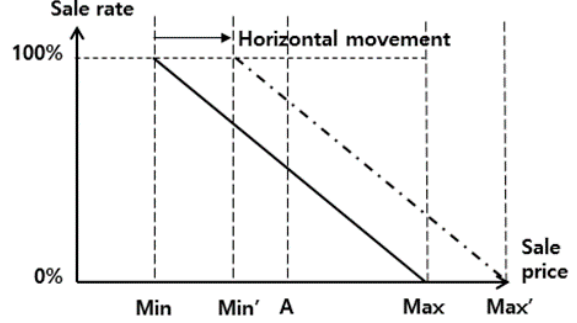
Figure 9. Horizontal movement of graphs according to itemized.